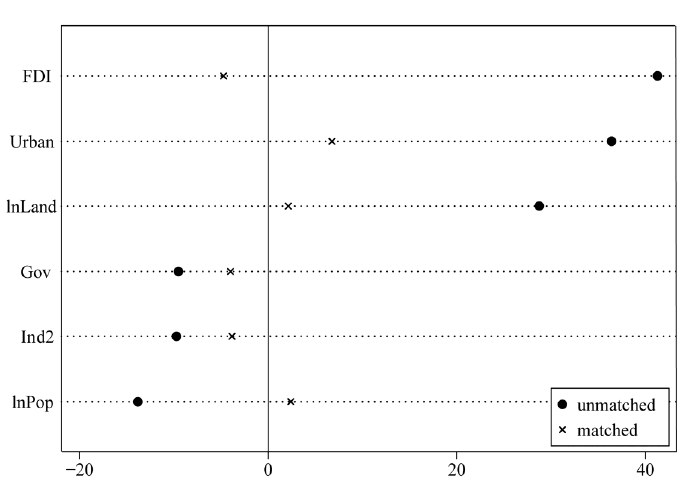
Figure 4. The deviation in each covariate for the treatment and control groups.